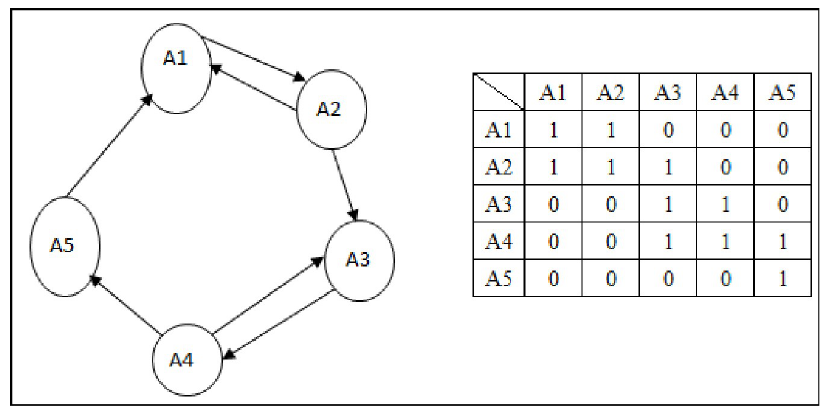
Fig 1. Direct influence relationship and influence relationship matrix of system